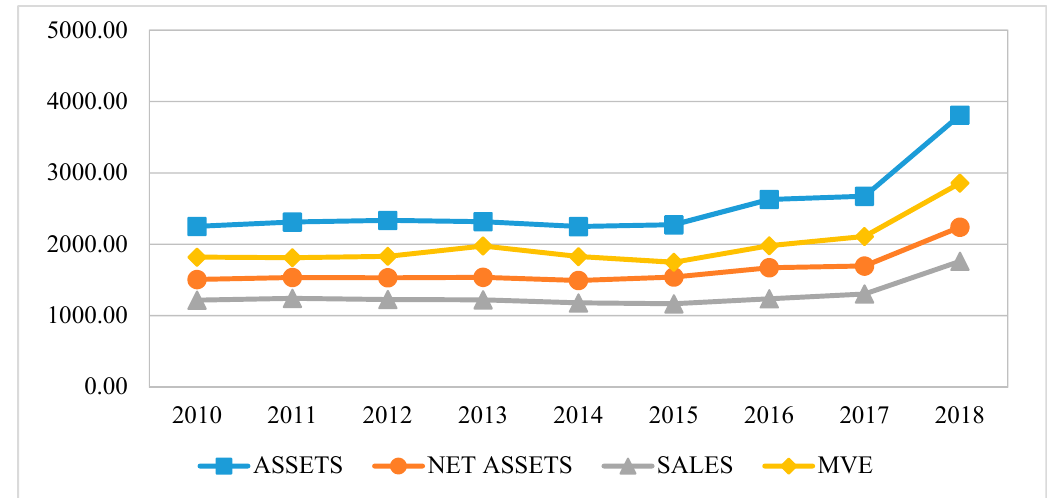
Figure A1. The trends of firm size measures (in logarithm terms). Note: This figure provides the time series of the average firm size measures in logarithm terms for all the firms in the sample data.